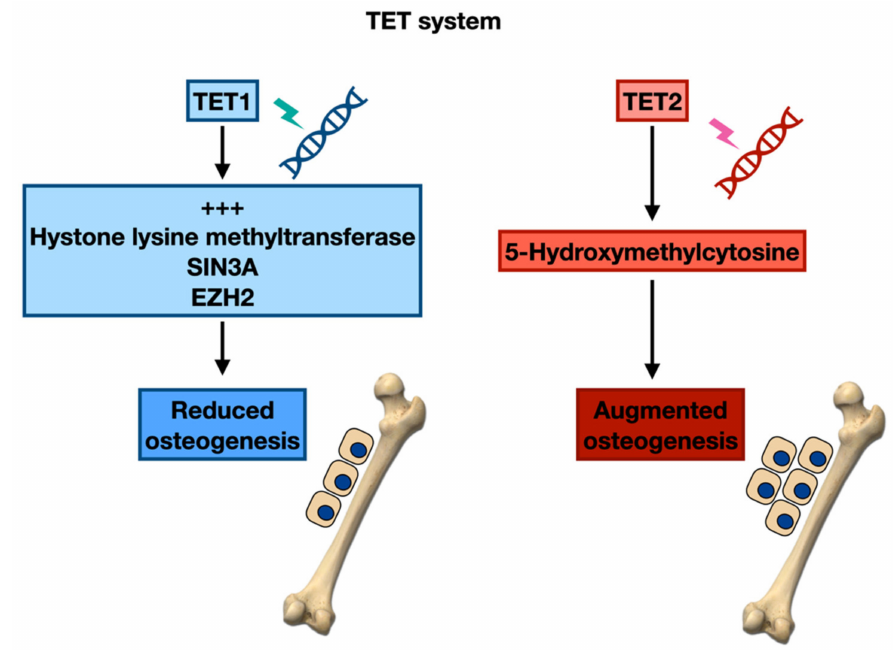
Figure 3. TET system’s influence on